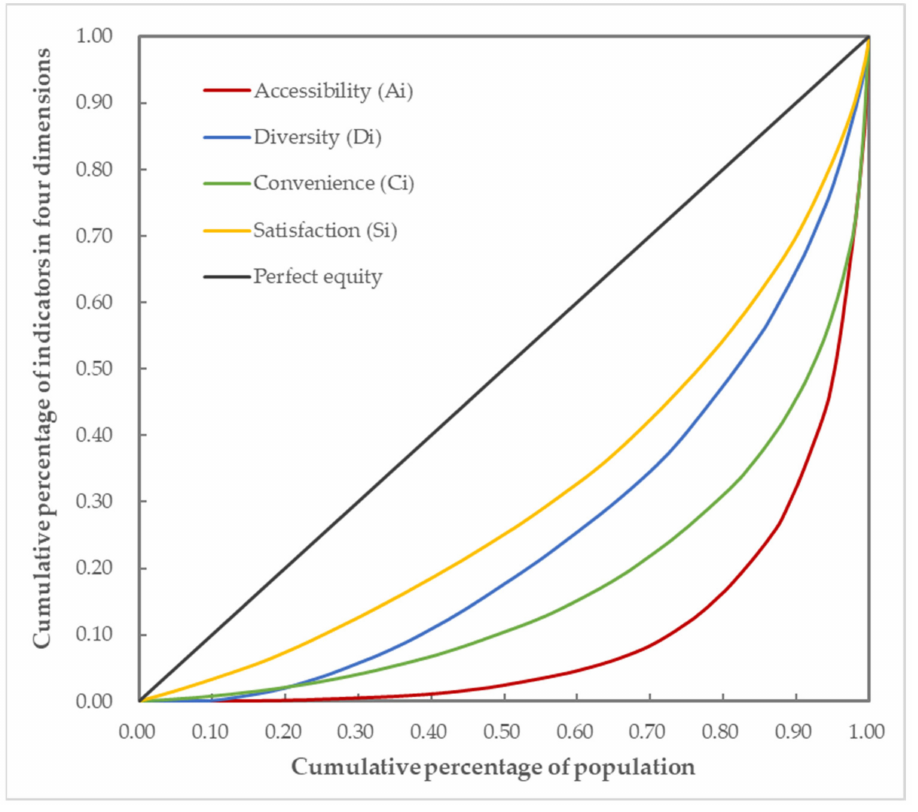
Figure 8. Lorenz curve of the four dimensions. Table 8. Gini coefficient of the four